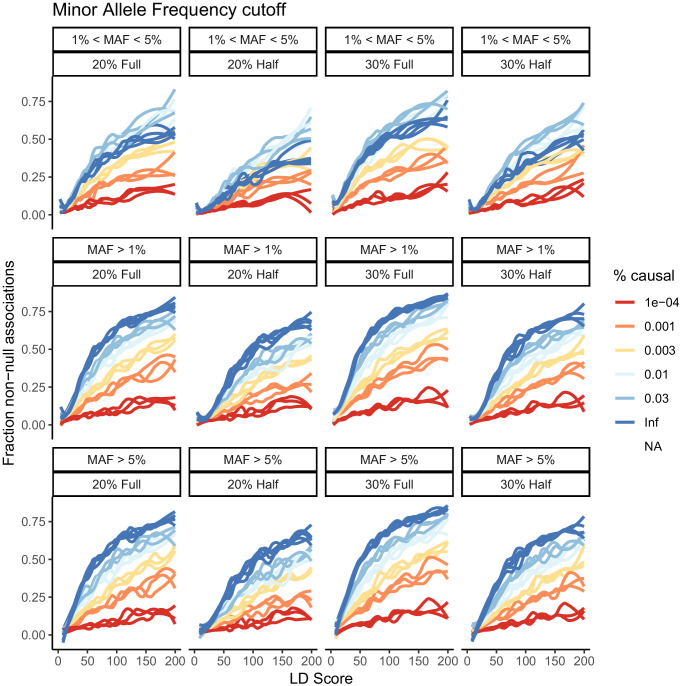
Effect of minor allele frequency cutoff on the estimates obtained.Three choices are considered – MAF >1%, MAF >5%, and MAF between 1% and 5%. There is some attenuation of the estimates in the MAF between 1% and 5% analysis, and the infinitesimal estimates are below that of the models with fewer causal sites, supporting the notion that power is still limiting.